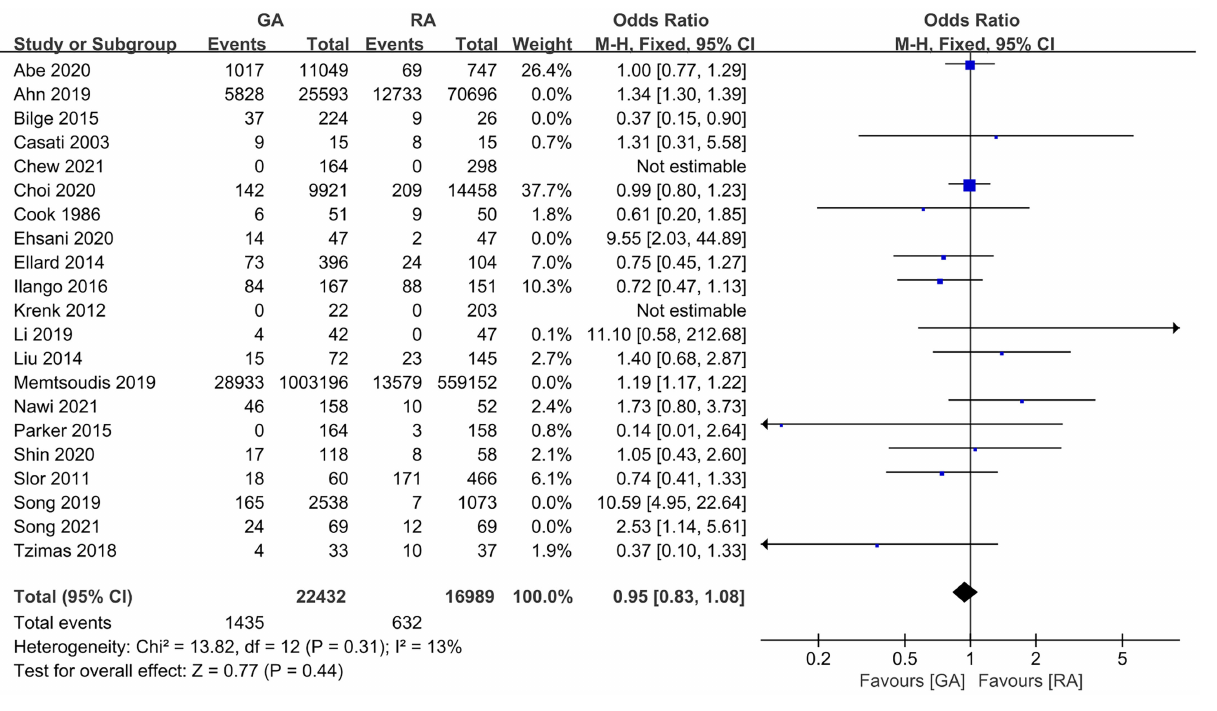
FIGURE 4 | The pooled result of POD incidence in surgical patients with GA and RA after sensitivity analysis.